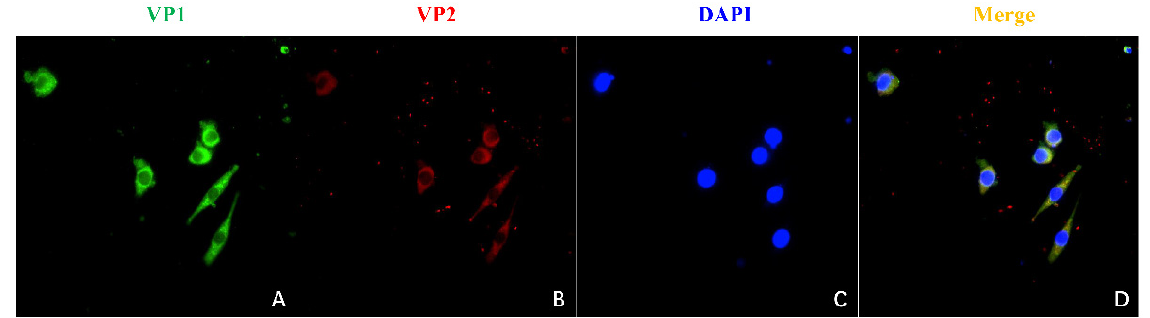
Figure 3. Identification of pBud-VP1-VP2 expression by IFA. ( A ): IFA detection with mouse anti- VP1 antibody. ( B ): IFA detection with rabbit anti-VP2 antibody. ( C ): Staining with DAPI. ( D ): Merge of A, B, and C.